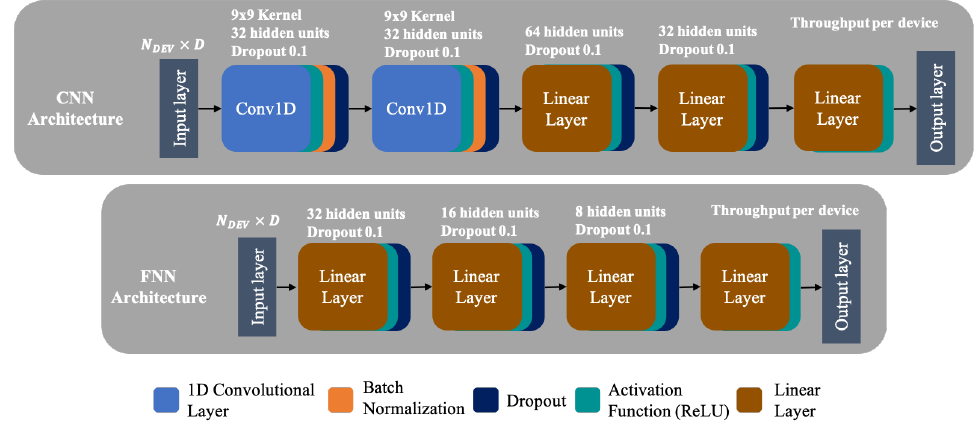
Figure 4. Architecture of the state-of-the-art ML